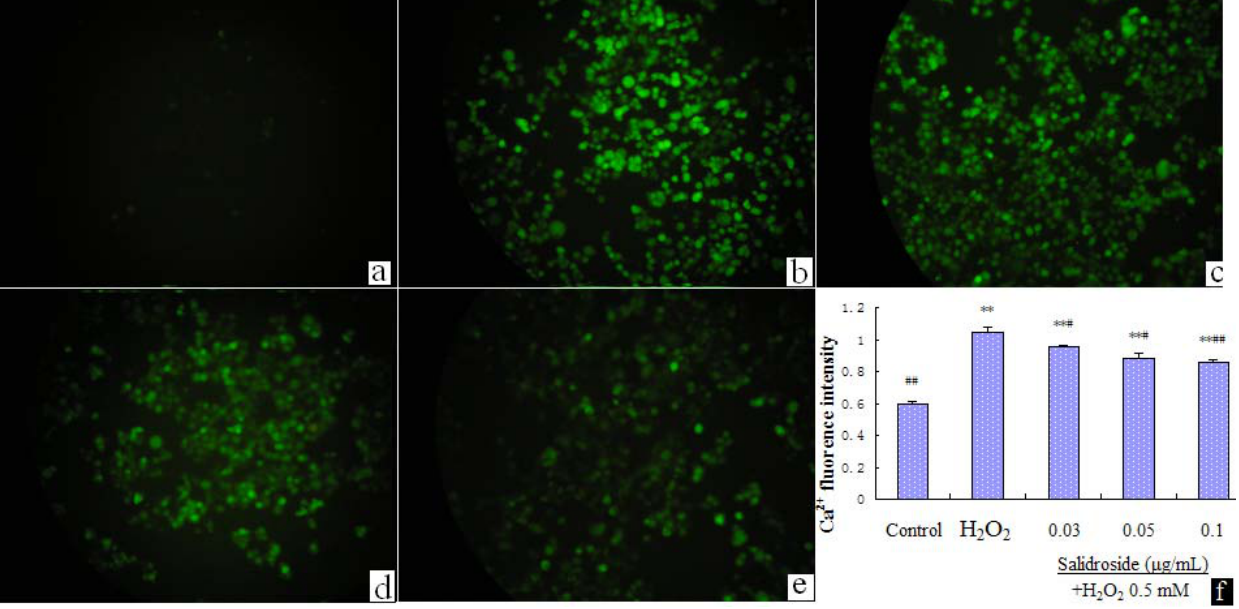
O -induced cell damage. Cells were treated 2 2 O as described in 2.2 and cell viability was determined by 2 2